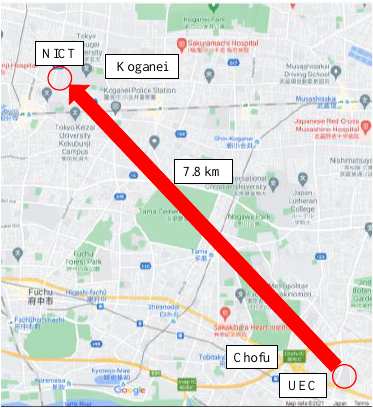
Figure 3. Map of Tokyo FSO testbed ( 🄫 2020 Google).